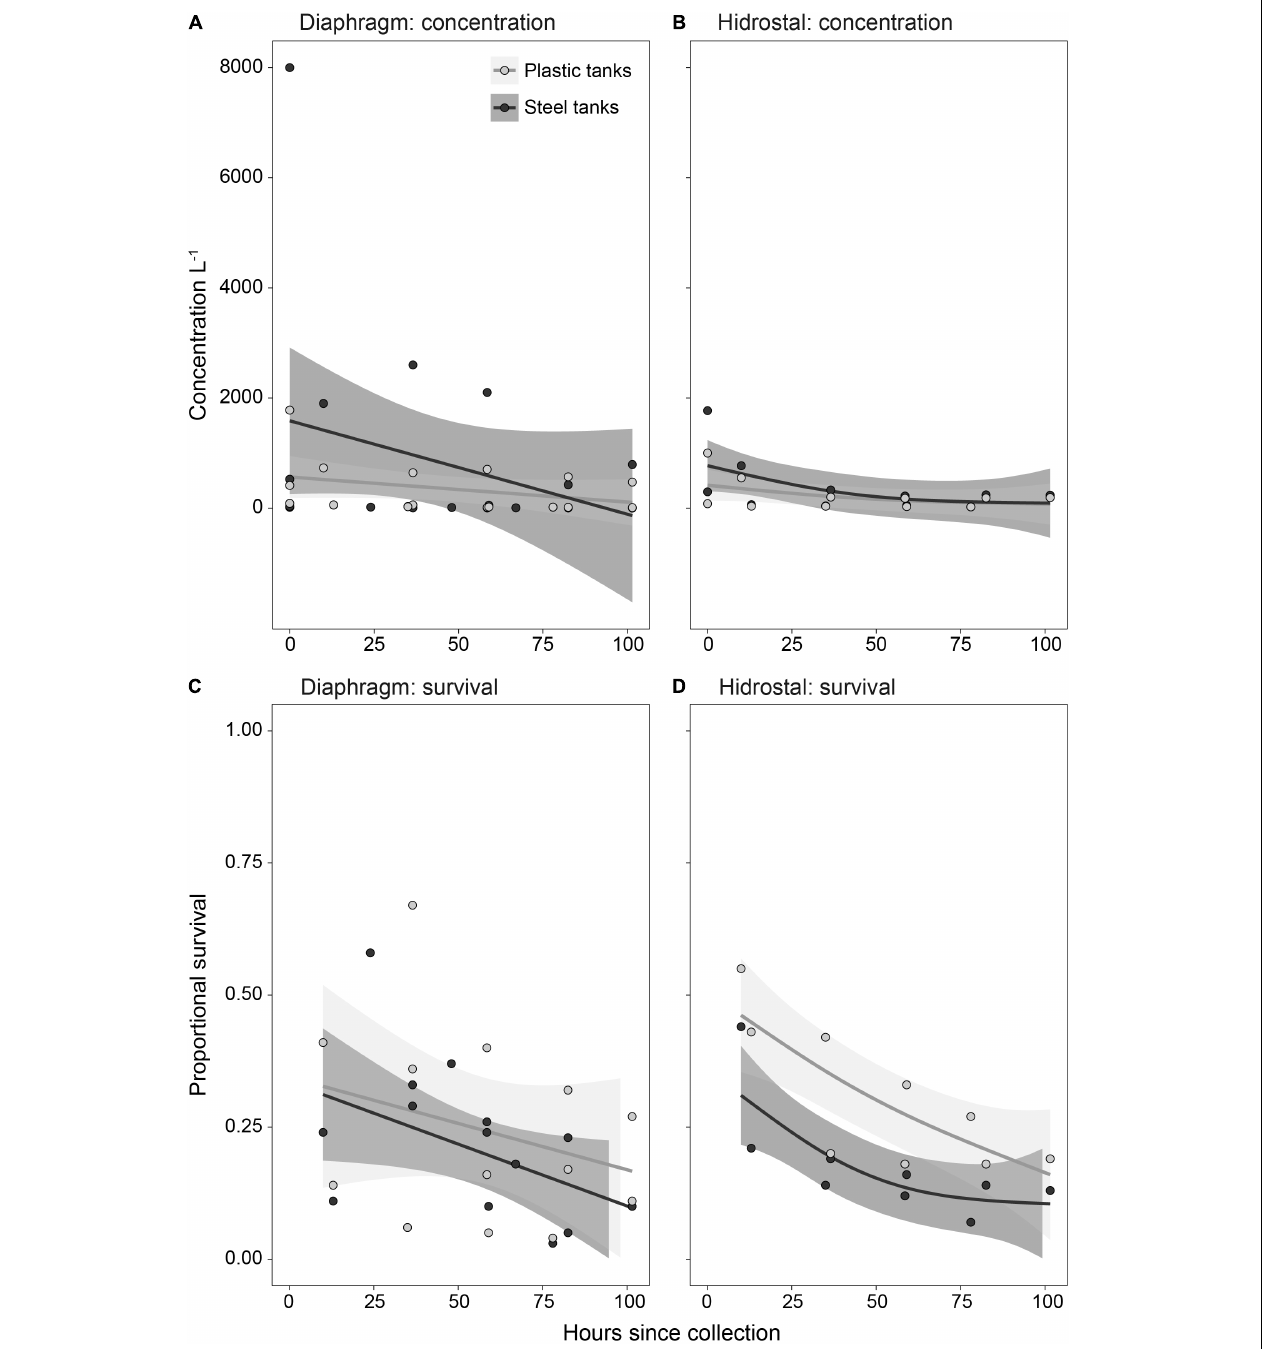
FIGURE 7 | Temporal trends in larval (A,B) concentration and (C,D) proportion survival following pumping by diaphragm and Hidrostal pumps in the plastic and steel tanks. Solid circles represent individual data points, solid lines represent mean of the generalized additive model fits, and shading is the 95% confidence interval of model fits ( n = 3 per tank type for the diaphragm pump; n = 2 per tank type for the Hidrostal